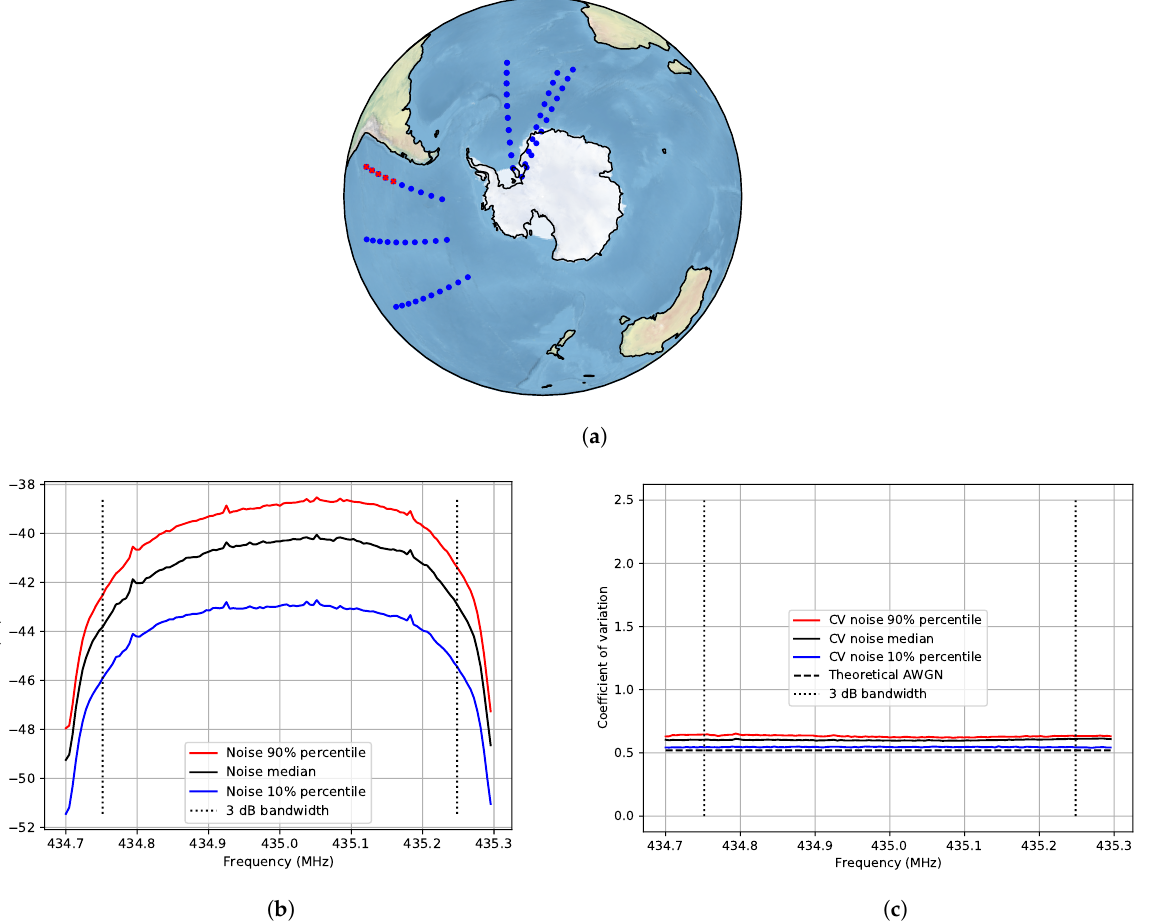
Figure 6. Time-frequency behaviour of measurements over non-populated areas. ( a ) Sub-satellite points for measurements over non-populated areas (blue circles) and close to populated areas (red circles). ( b ) Spectrum of average power ( m 2 k ). ( c ) Coefficient of variation (CV). A high coefficient indicates high spread in the measured